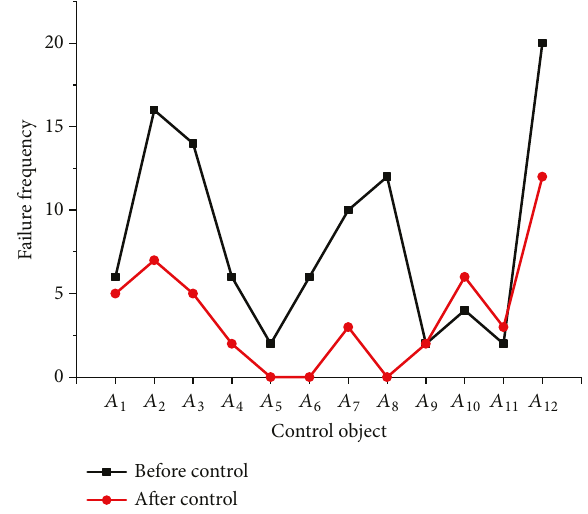
Figure 7: Comparative analysis of failure frequencies before and after critical coupling fault node